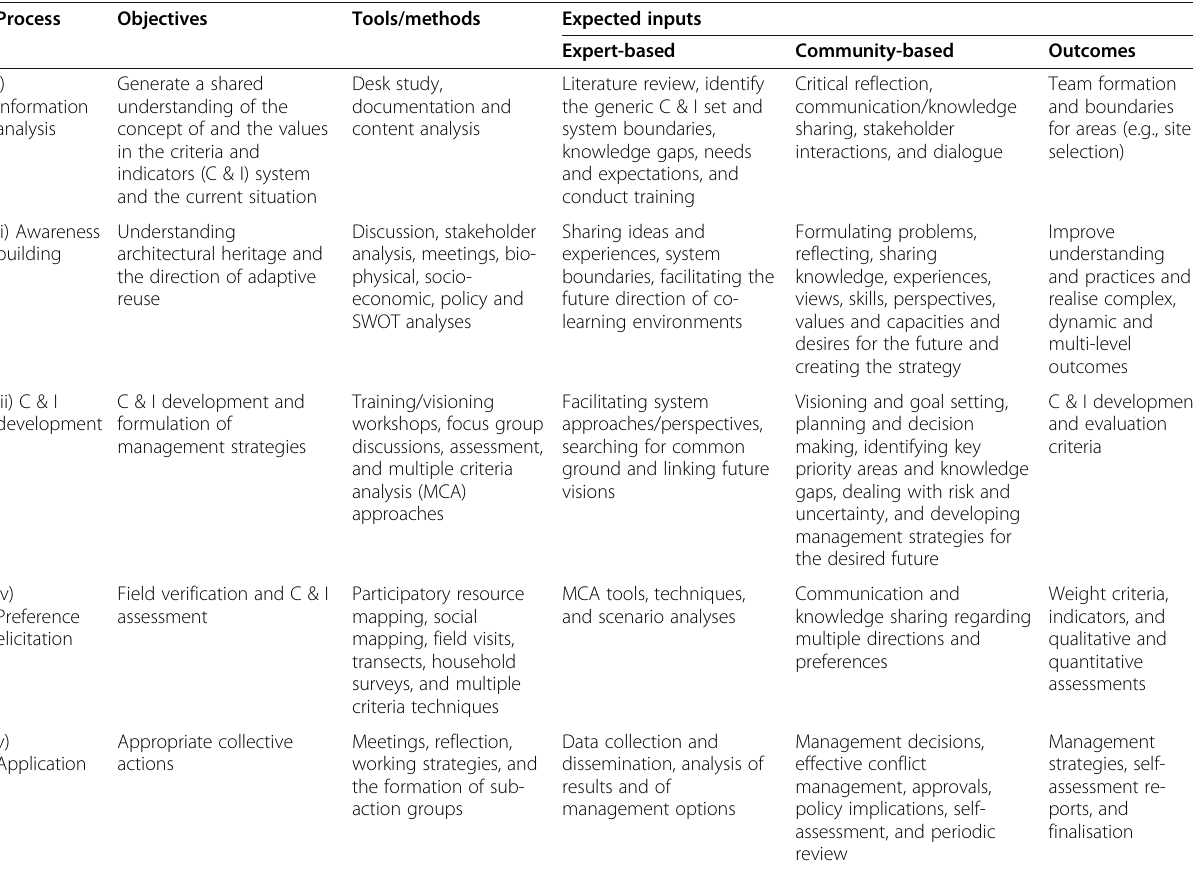
Table 1 The operation of the BU approach to studying the adaptive reuse of architectural heritage based on the preference measurement